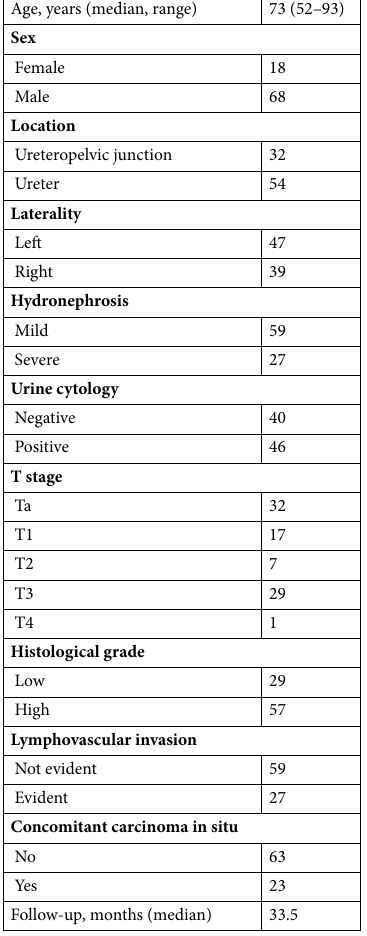
Table 1. Characteristics of the 86 patients with upper tract urothelial